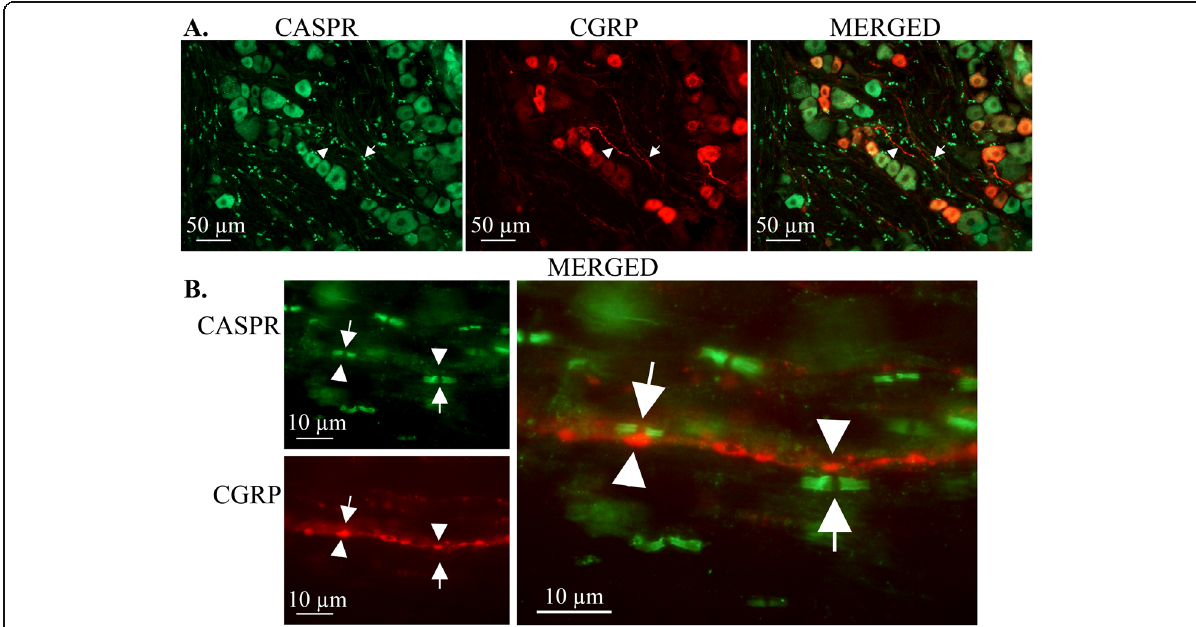
Fig. 4 Immunolocalization of CGRP in rat trigeminal ganglia in relation to CASPR-positive axonal nodes. a The CGRP Ab labeled smaller neurons and thin fibers (arrowhead) within the ganglia. Double staining with the CASPR Ab (arrow) showed no co-localization (merged). b Higher magnification shows a CGRP-labeled axon in close proximity to CASPR-positive axons. CGRP-containing axonal varicosities (arrow), which are putative release sites, align directly across from CASPR-positive nodes of Ranvier (arrowhead) on the adjacent